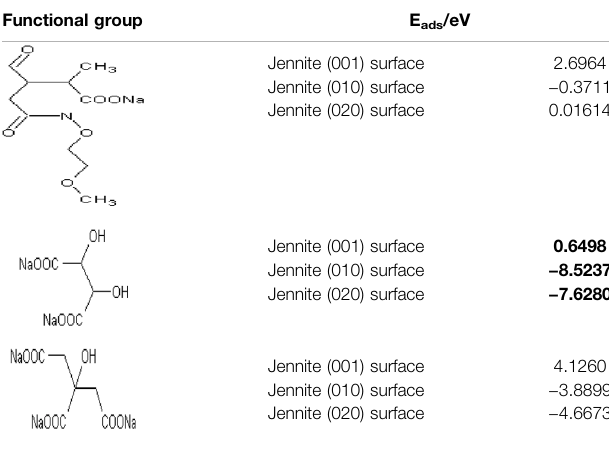
TABLE 6| Calculationsoftheadsorption energybetweenthedifferentadmixtures and jennite. Functional group